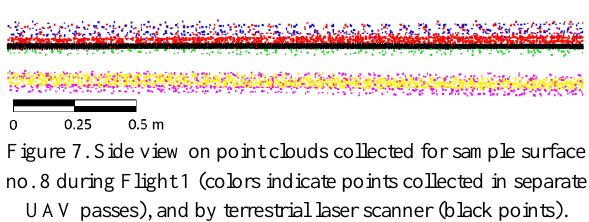
Figure 7. Side view on point clouds collected for sample surface no. 8 during Flight 1 (colors indicate points collected in separate UAV passes), and by terrestrial laser scanner (black points).